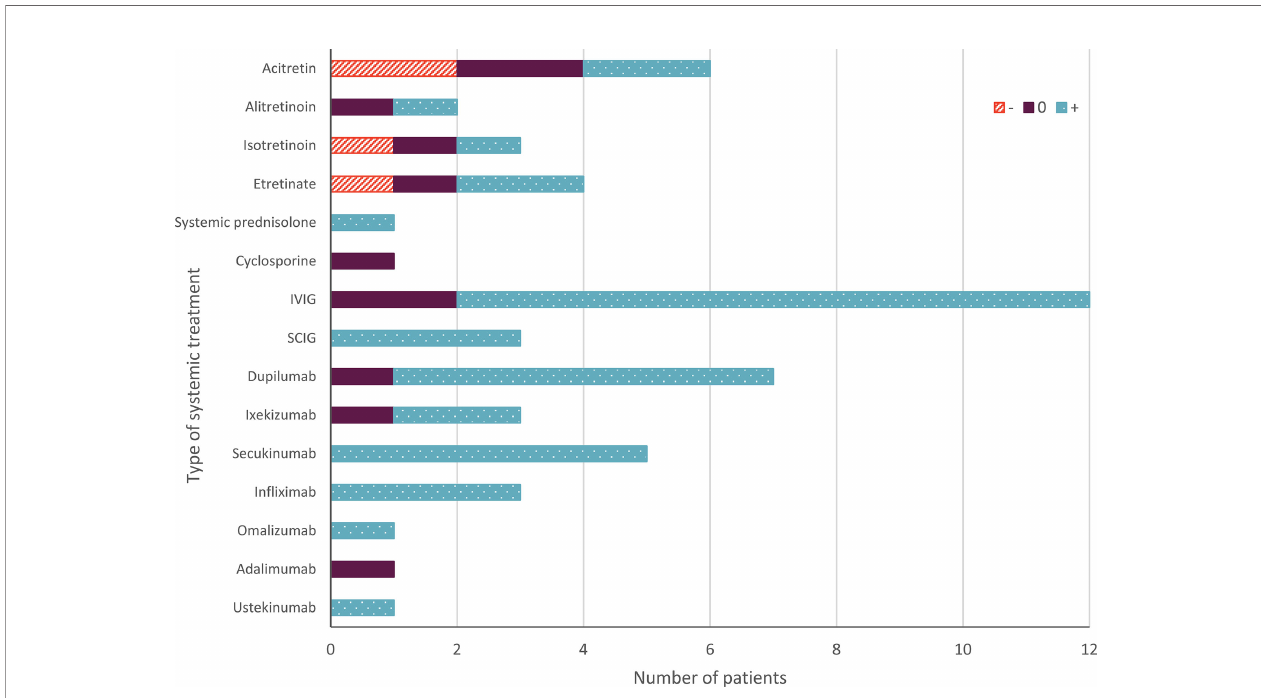
FIGURE 2 | Overall effect of systemic treatment in Netherton syndrome. The orange upward diagonal lines indicate worsening (-) the skin condition; blue with white dots indicates improvement (+) of the skin condition. Purple indicates no change; or temporary improvement; or a combination of worsening and improvement; or temporary worsening (0). The number of patients on the X-axis indicates absolute numbers. IVIG, intravenous immunoglobulins; SCIG, subcutaneous